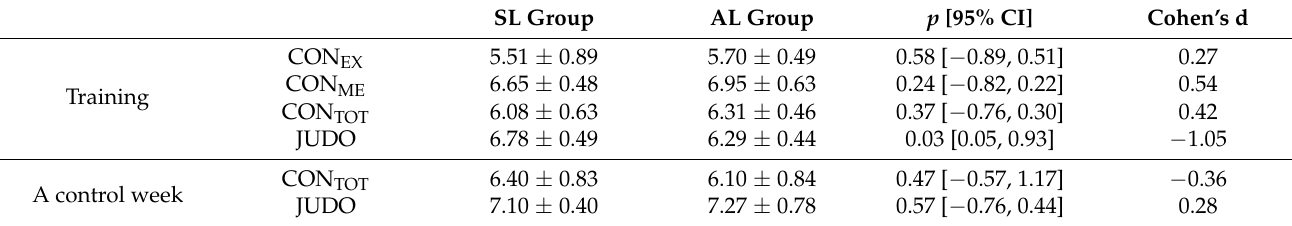
Table 2. Rating of perceived exertion (RPE-10) in the training and control weeks in both groups. SL Group AL Group p [95% CI] Cohen’s d CON Training